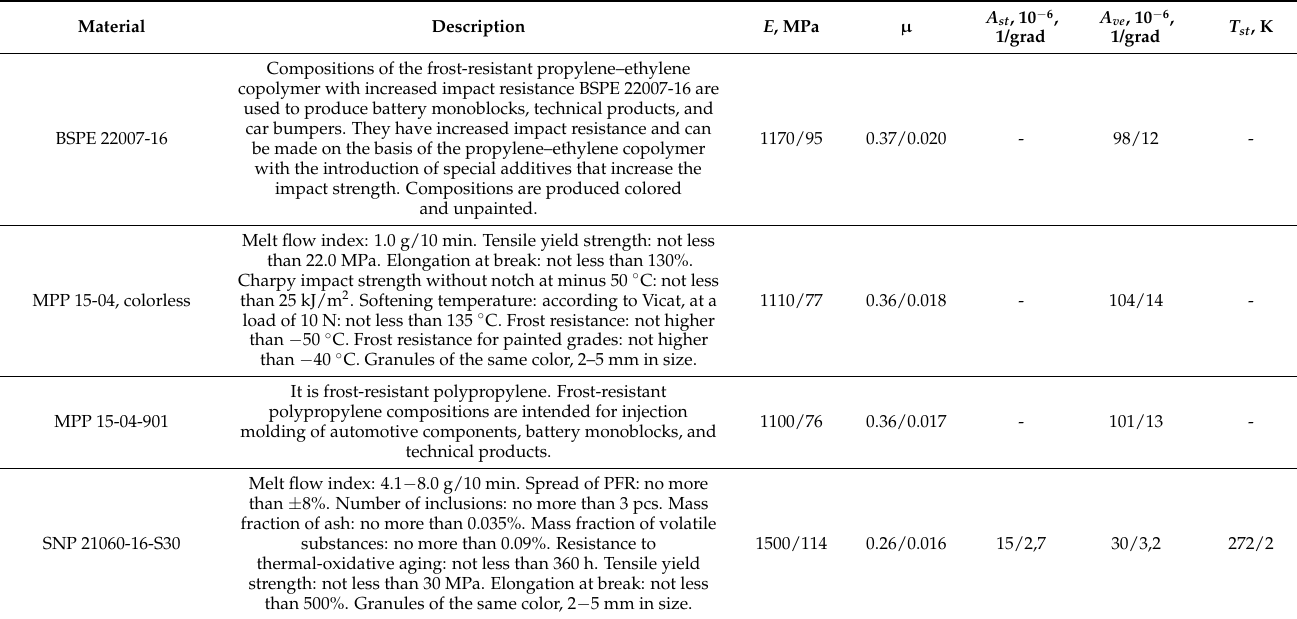
Table 1. Statistical characteristics of polypropylene